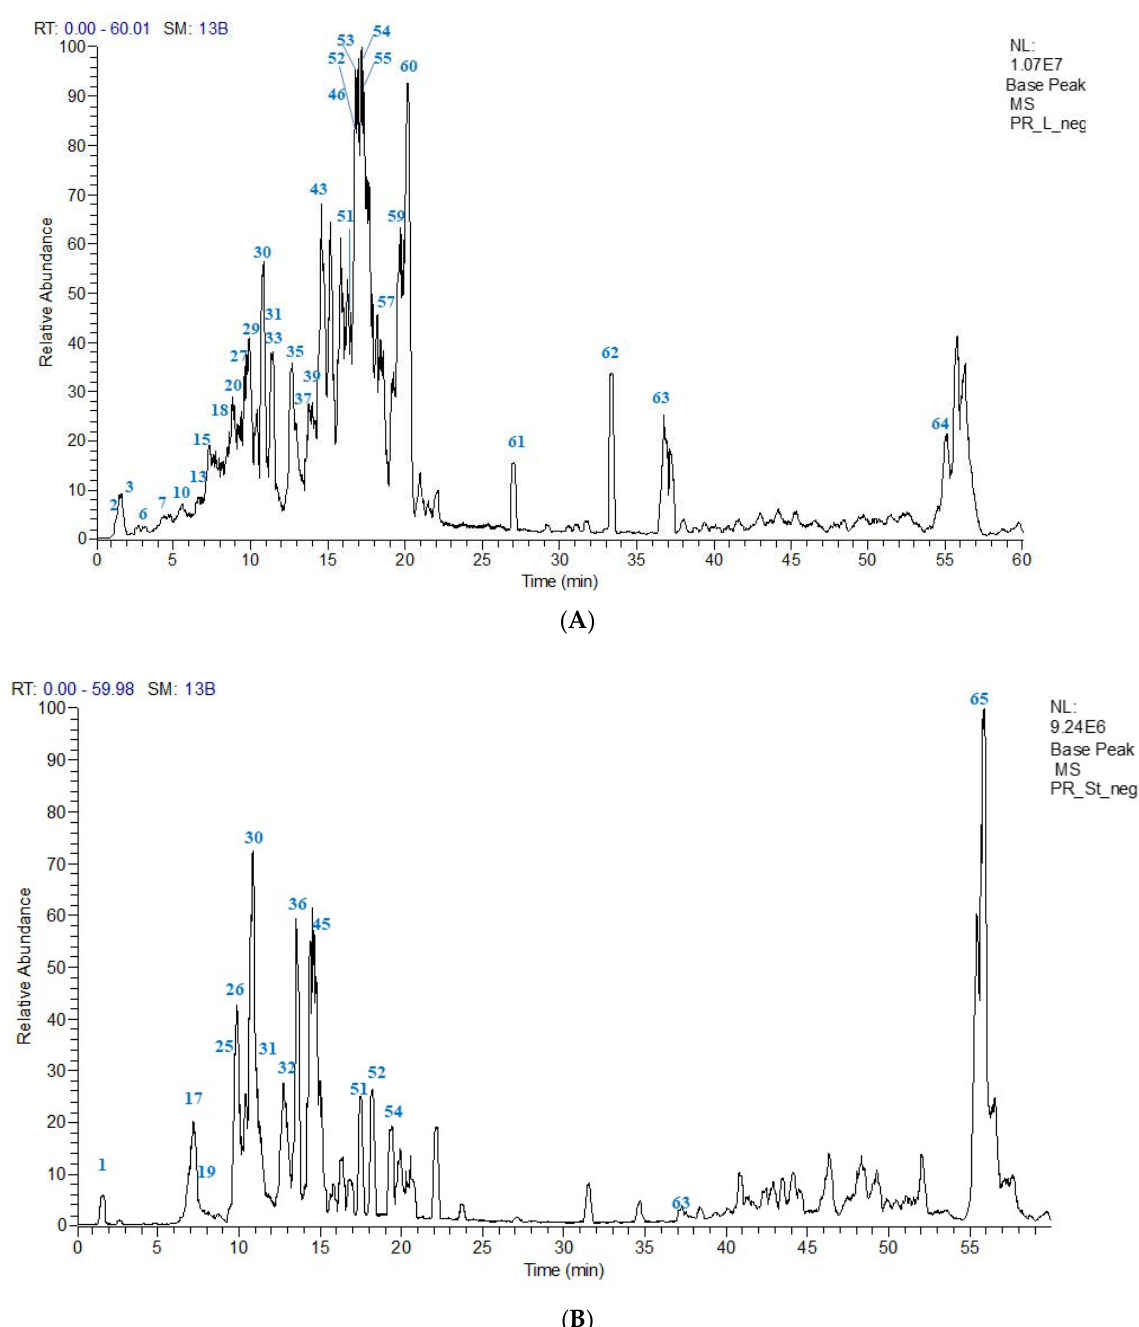
Figure 3. ( A ) UPLC-ESI-MS base peak chromatogram of P. racemosa leaves methanol extract (PRL-Me) in the negative ion mode. ( B ) UPLC-ESI-MS base peak chromatogram of P. racemosa stem